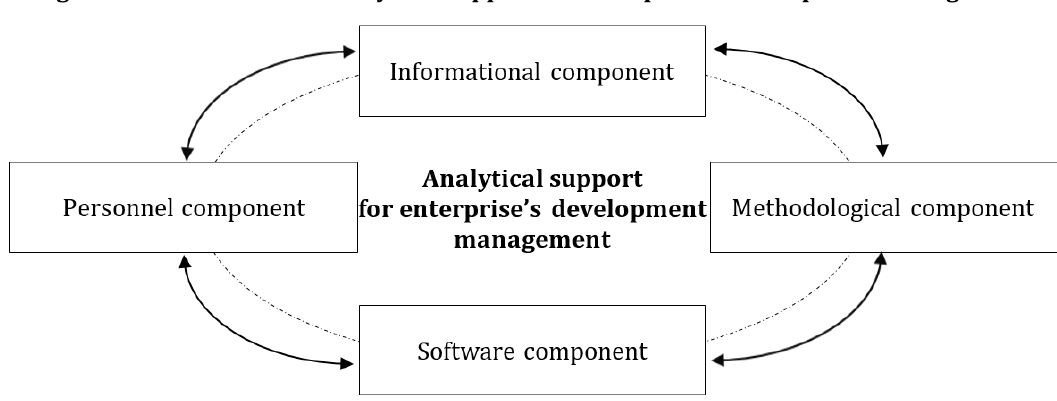
Source: developed and proposed by the